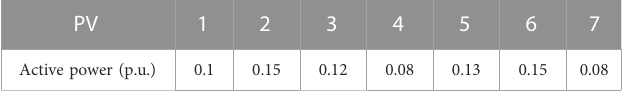
TABLE 2 Equivalent parameters of the UD model. TABLE 1 Original parameters of